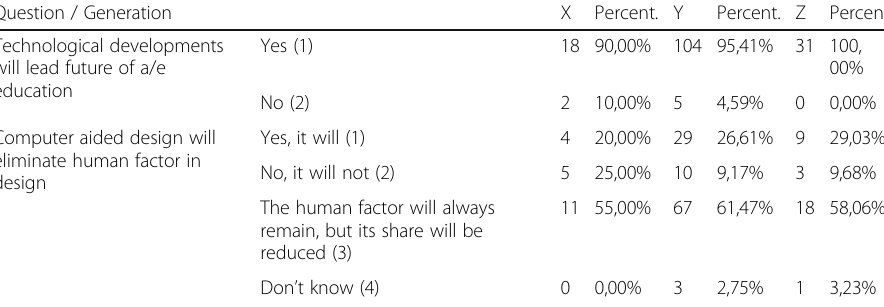
Table 5 Technology and Education Related Expectations of Generations Question / Generation X Percent. Y Percent. Z